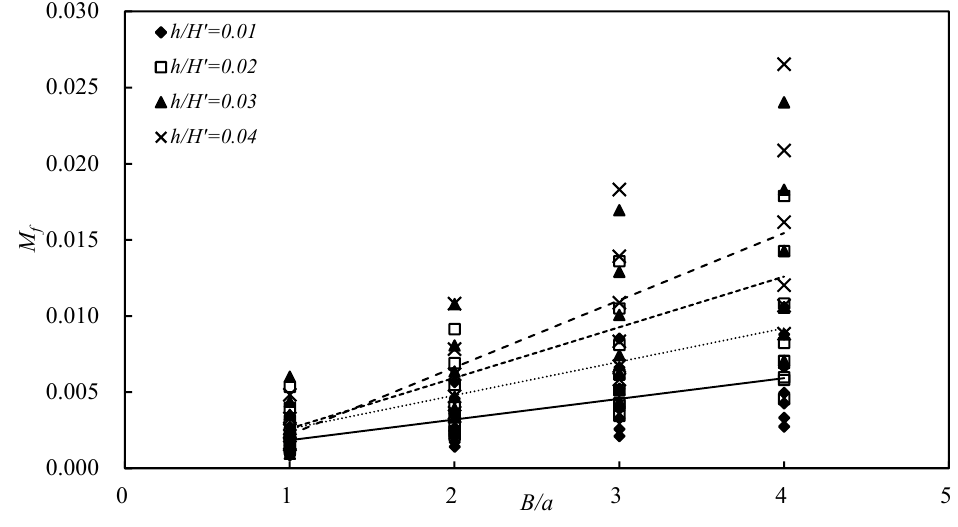
Figure 5. Relationship between M f and the floating structure’s shape.